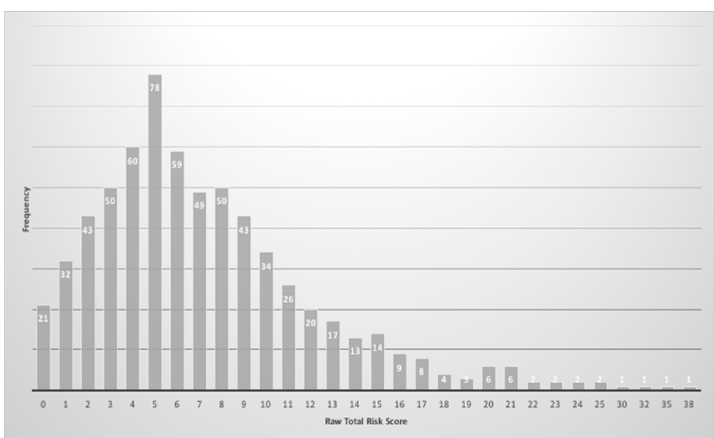
Figure 2. Distribution of First Year Inventory (FYI) raw risk scores in the Italian sample according to the factor structure of Reznick et al. (2007).